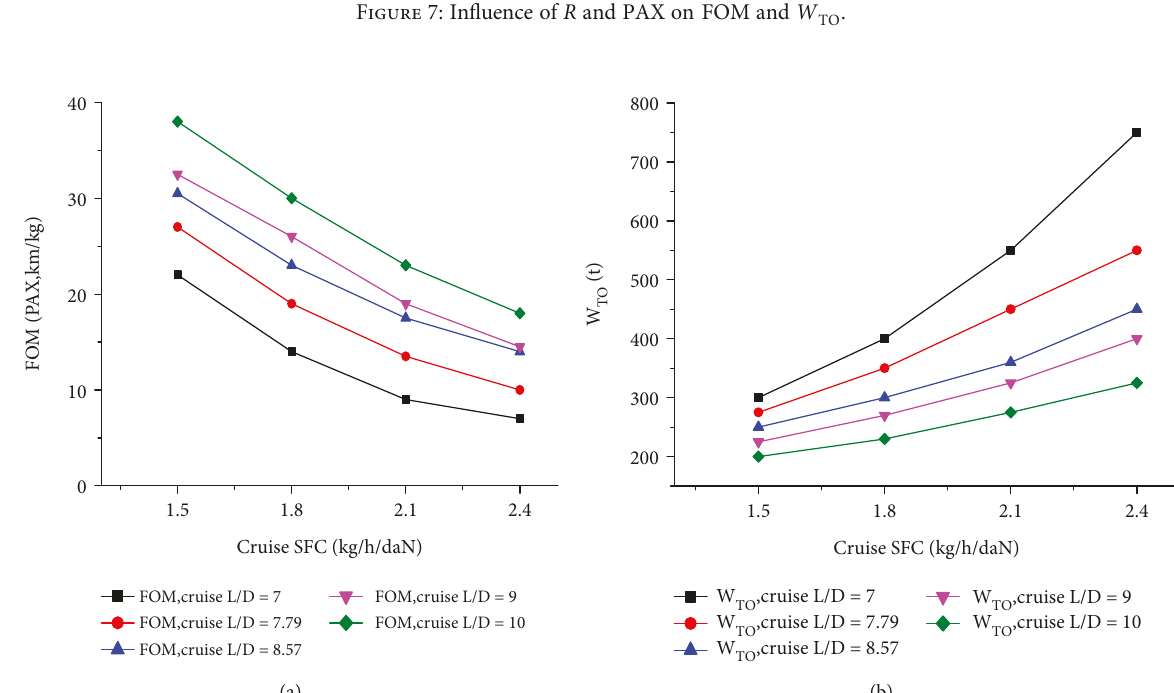
Figure 8: In fl uences of cruise L / D and cruise SFC on FOM and W